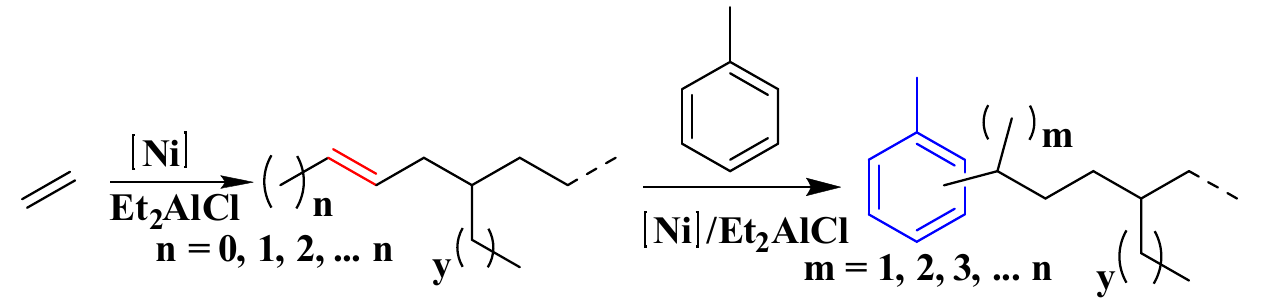
Figure 2. 1 H NMR spectrum (C 6 D 6 ) of representative oligomer samples from Table 1, entries 1 ( A ), 7 ( B ) and 8 ( C ).